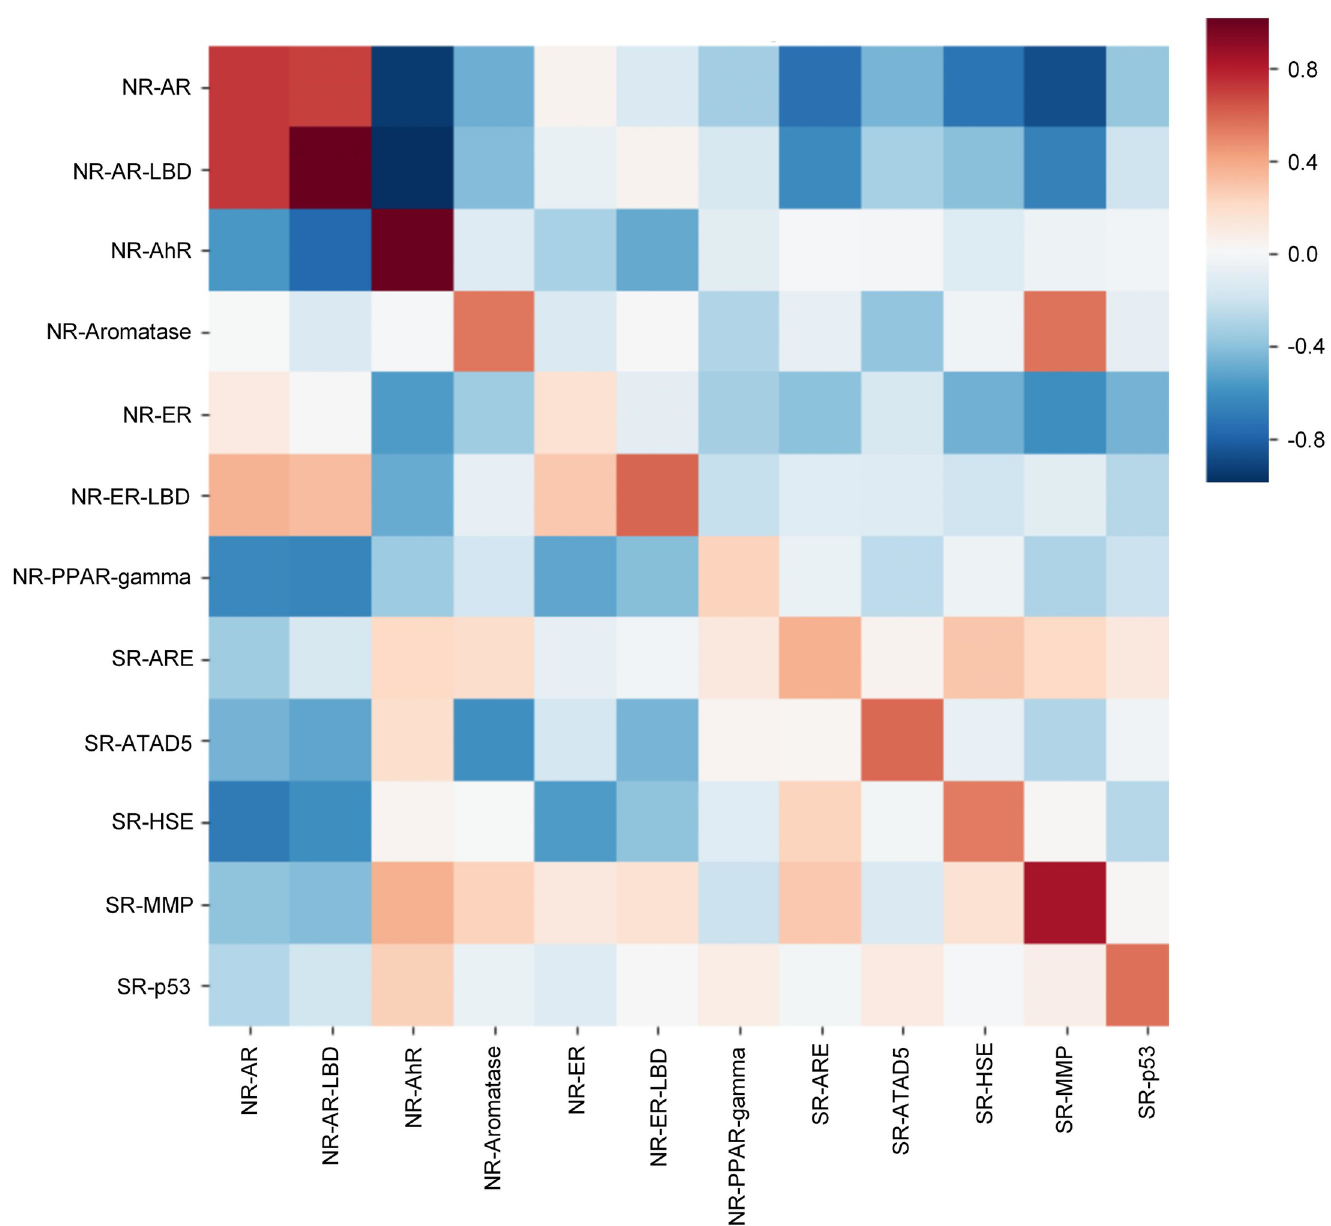
Fig 9. The correlation between predictions and observations of our model on different tasks in tox21 data set (index split).